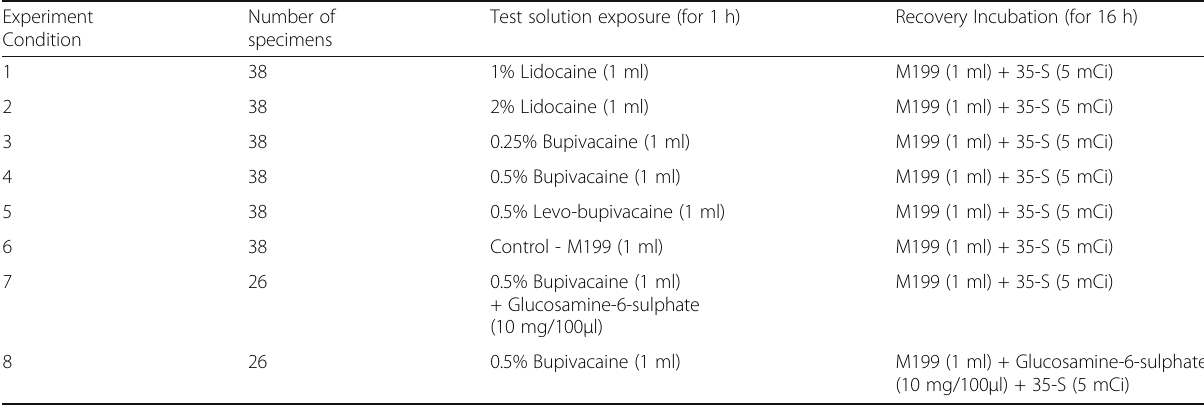
Table 1 Experimental conditions used to test the effect of local anaesthetics and Glucosamine on articular cartilage. Radio-labelled sulphur (35-S) uptake was compared to the control solution (M199) Experiment Number of Condition